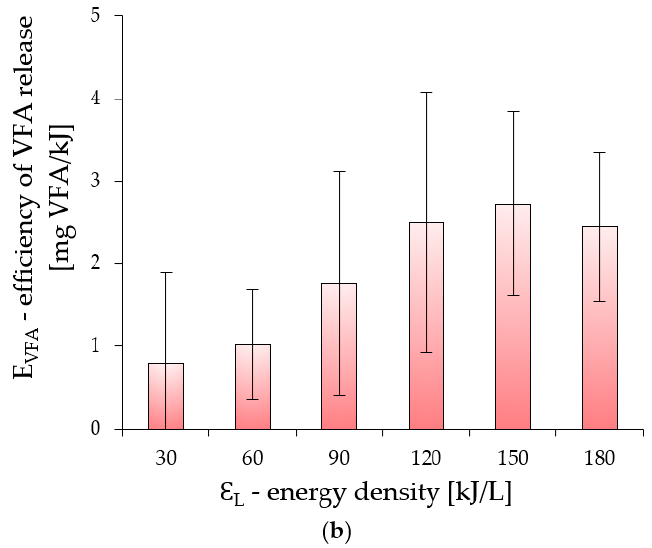
Figure 4. Effect of energy density on the efficiency of SCOD ( a ) and VFA ( b ) release from thickened waste activated